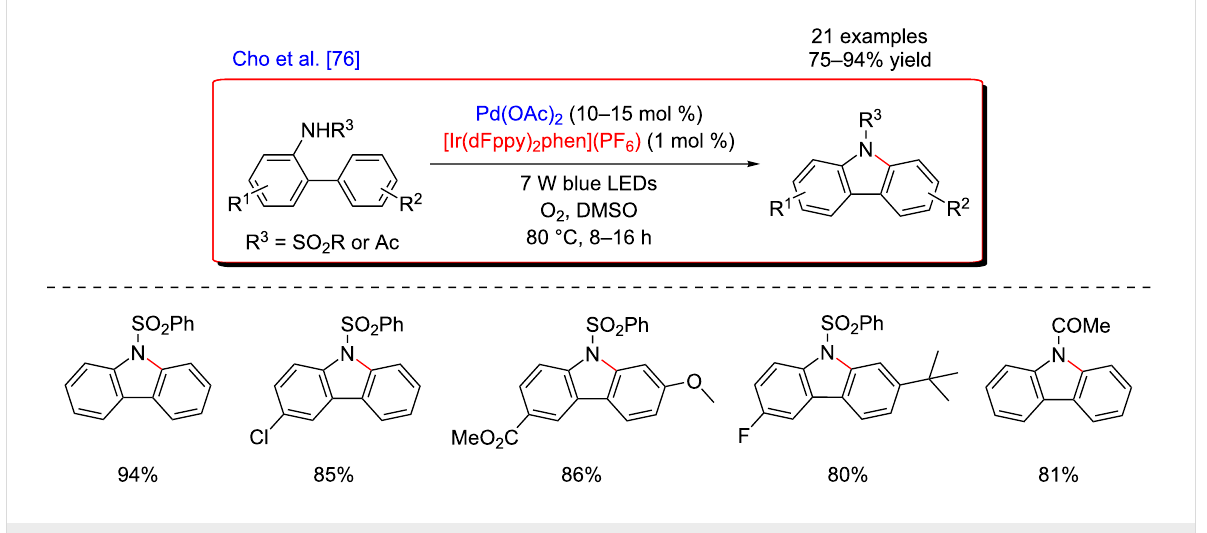
Figure 11: Carbazole synthesis via dual C–H activation/photoredox catalysis.